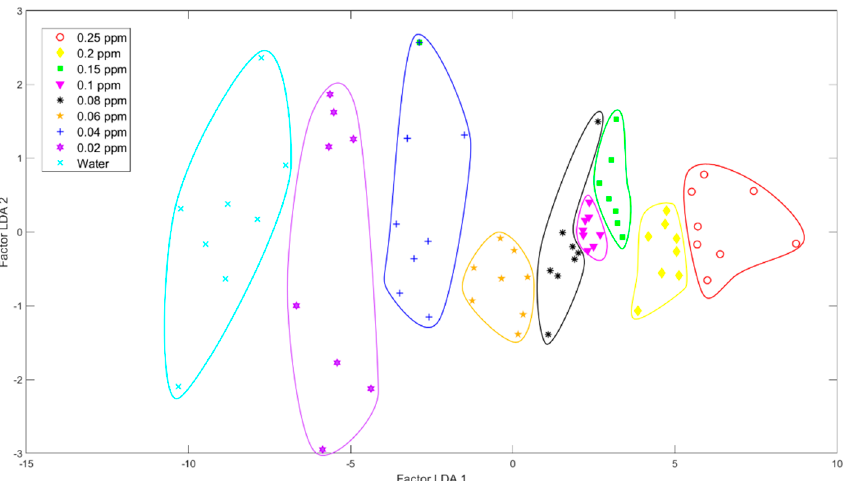
Figure 15. LDA plot using the carbon electrode (C110) to classify Numetrin pesticide at different concentrations against distilled water.